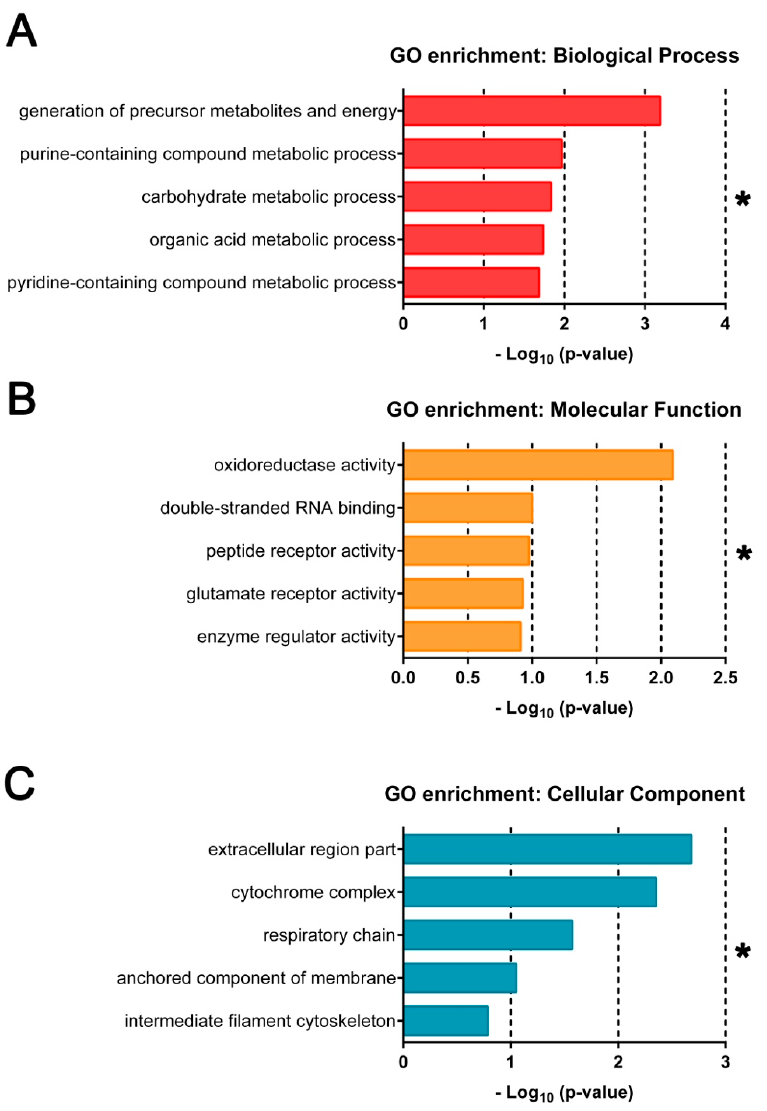
Figure 3. Gene ontology terms enriched by over representation analysis and gene set enrichment analysis of all differentially expressed genes. GO annotations associated with most highly DE genes ( n = 286, FDR < 0.1, |log 2 (FC)| ≥ 1) enriched across all ages (12, 18 and 24 hpf) and Vitamin E (VitE) status by over-representation analysis. Terms are separated by ( A ) Biological Process, ( B ) Molecular Function and ( C ) Cellular Component. * indicates significant FDR < 0.25 with all enrichments shown considered significant.